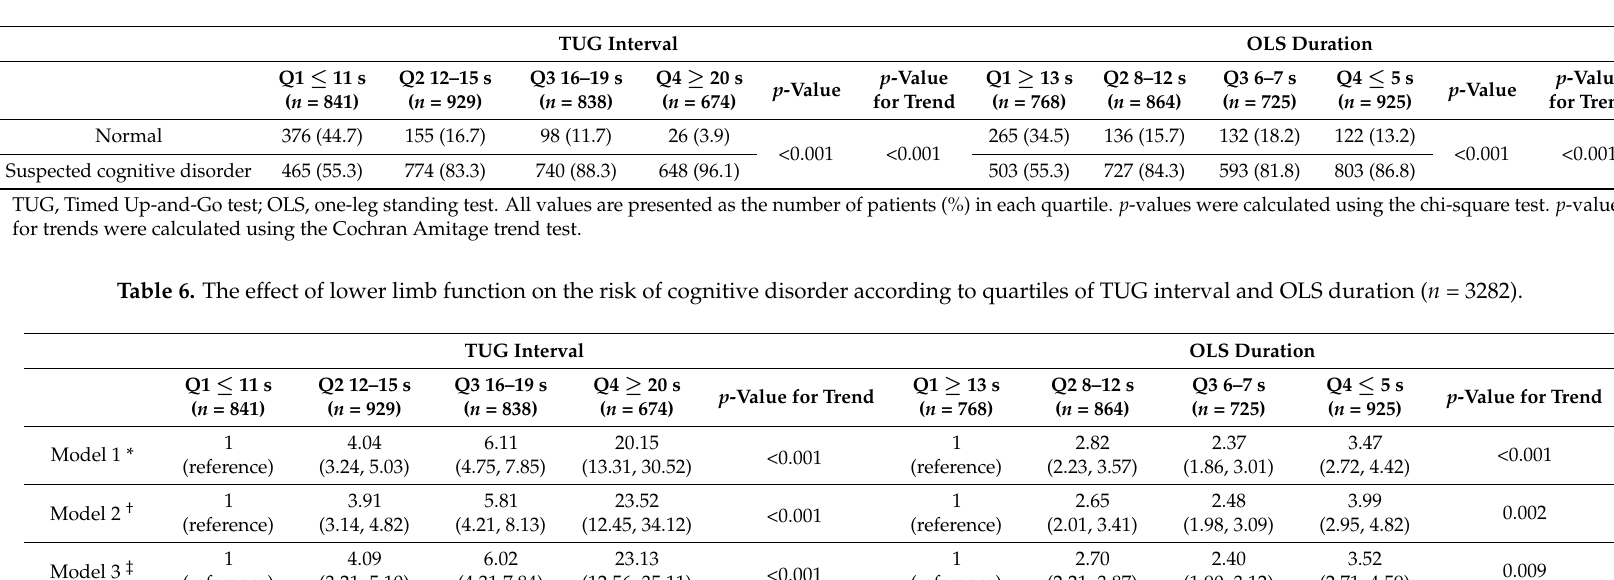
Table 5. Proportion of subjects with suspected cognitive disorders in the TUG interval and OLS duration quartiles ( n = 3282).